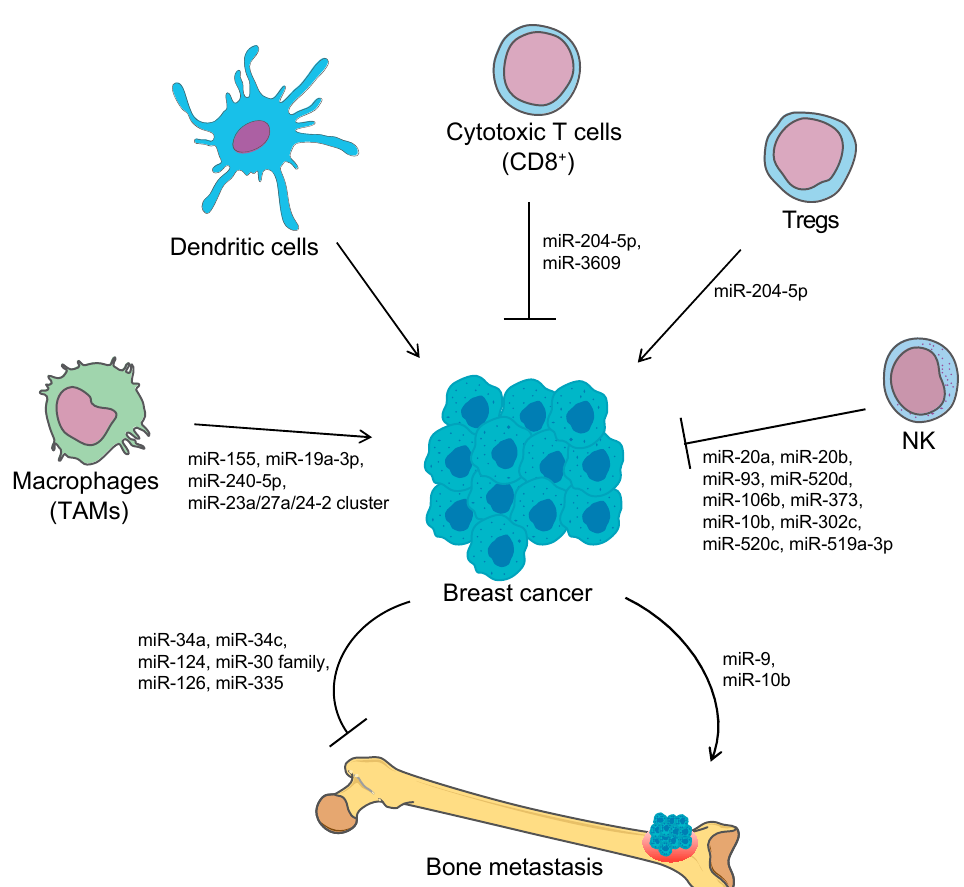
Figure 1. miRNAs involved in cancer-related immunity and bone metastasis in breast cancer. Interplay between immune cells that promote breast cancer growth and favor tumor microenvironment (arrows) and immune cells that inhibit breast cancer progression (dashed lines), with relevant miRNAs involved in the process. Other miRNAs are involved in the promotion or inhibition of bone metastasis of breast cancer. This figure was produced using Servier Medical Art available at https://smart.servier.com/. TAMs: tumor associated macrophages; Tregs: regulatory T cells; NK: natural killer cells.